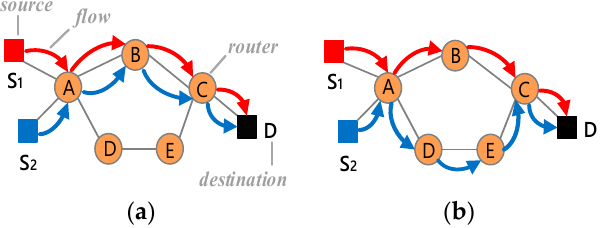
Figure 1. Flows that preempt the shortest path ( a ) can be shunted into two different paths ( b ) with DSCSD.